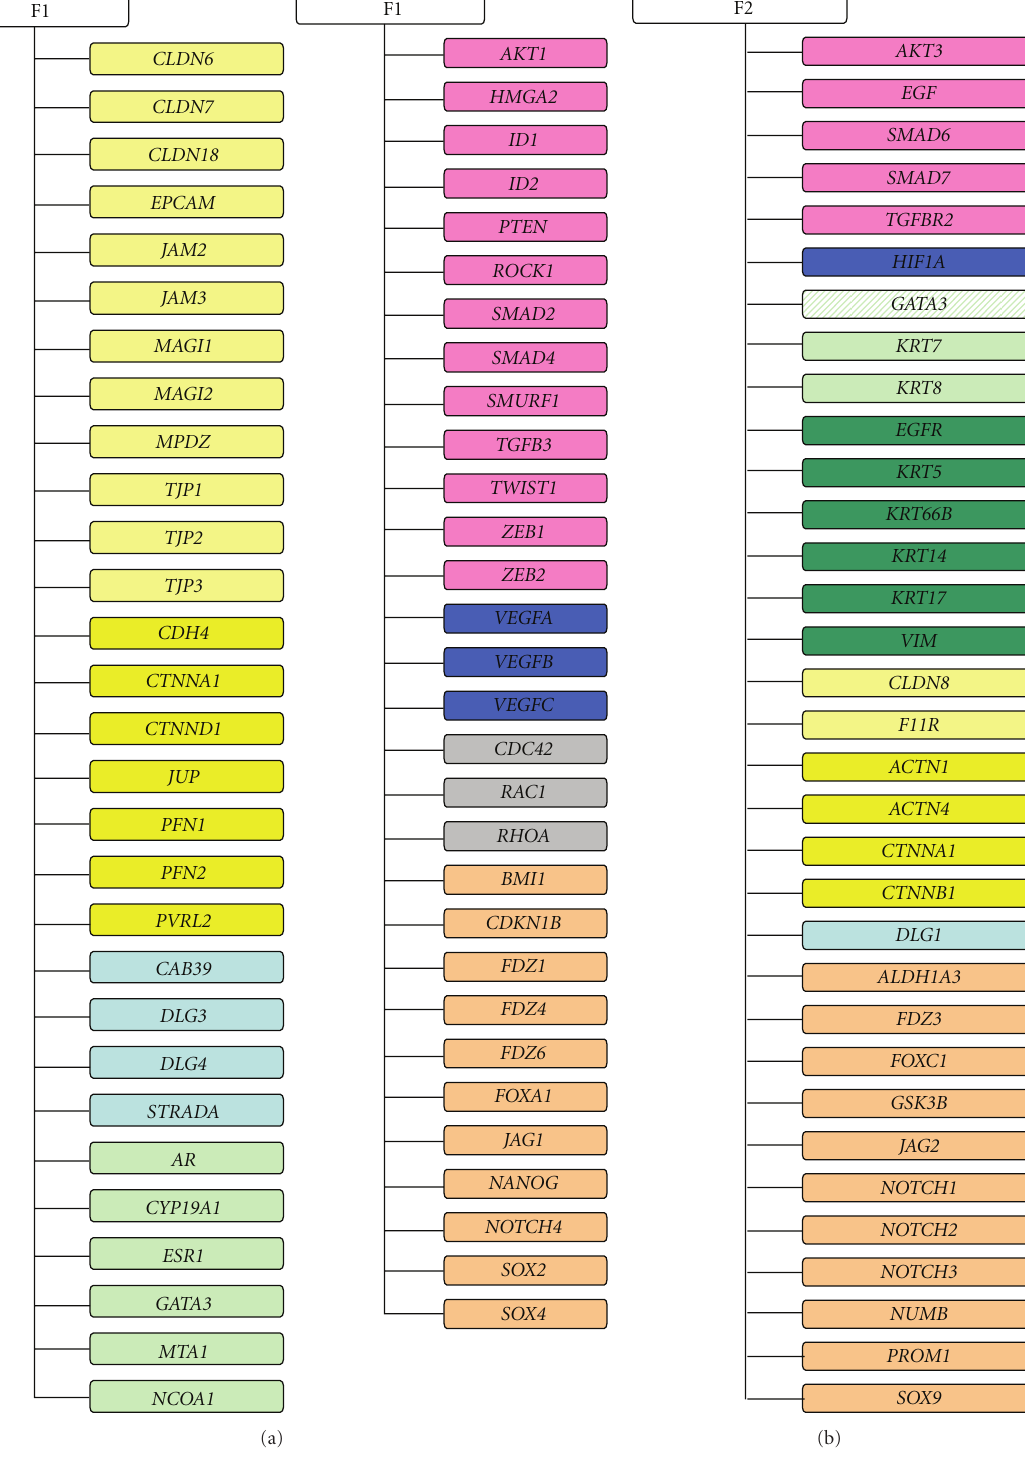
Figure 2: Factor analysis in ADH subgroup. Schematic representation of genes with a loading value < | 0 . 6 | characterizing the first (F1) and the second factor (F2). Solid color indicates a positive loading value whereas dashed color indicates a negative loading value. Color correspondence: light yellow , tight junction components; dark yellow , adherens junction components; light blue , polarity complexes components; dark blue , angiogenesis; orange , cell-fate decision; light green , luminal markers and hormone steroid; dark green , basal markers; pink , epithelial-mesenchymal transition, grey , GTPase family